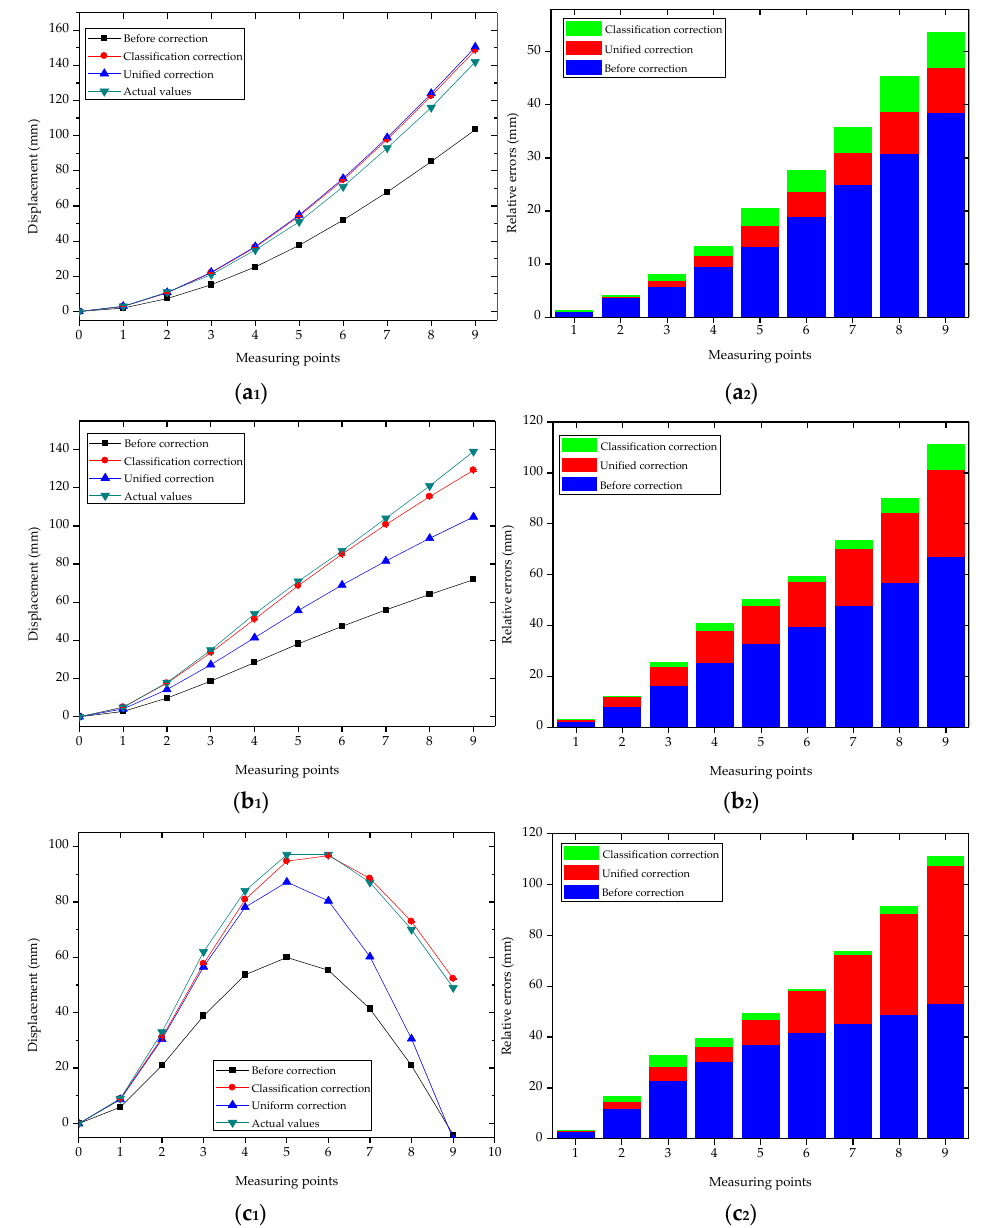
Figure 12. Demonstration of experimental results under three bending shapes of FBG implantable flexible morphological sensor. ( a 1 ) Displacement comparison of measuring points at Type 1. ( a 2 ) Relative errors comparison of measuring points at Type 1. ( b 1 ) Displacement comparison of measuring points at Type 2. ( b 2 ) Relative errors comparison of measuring points at Type 2. ( c 1 ) Displacement comparison of measuring points at Type 3. ( c 2 ) Relative errors comparison of measuring points at Type 3.